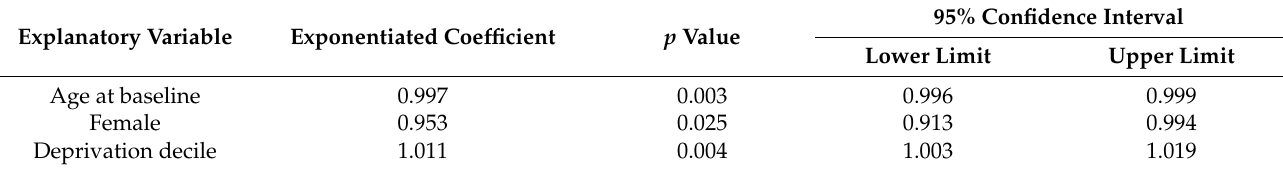
Table 6. Effect of age, sex, and deprivation decile (from modelling, after